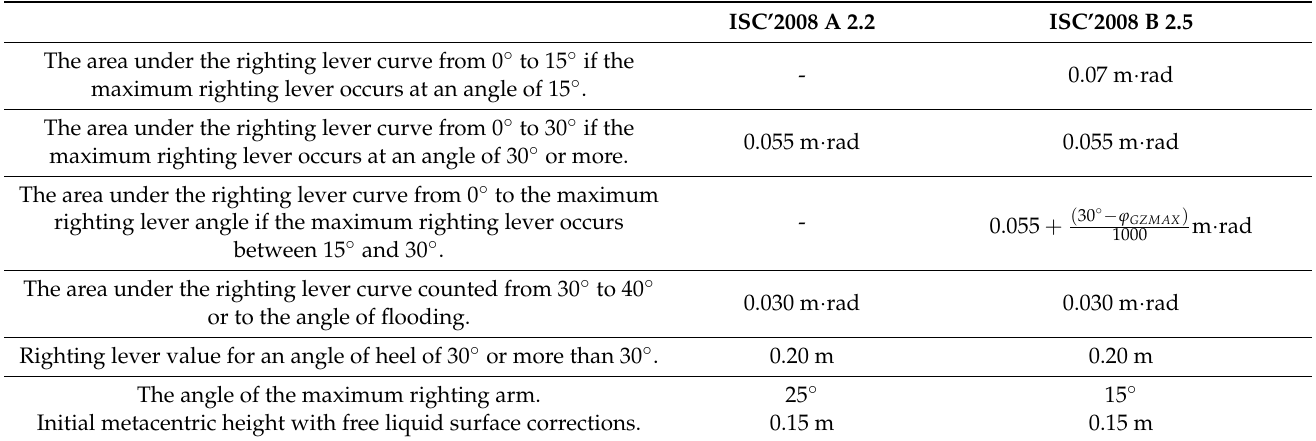
Table 1. Criteria of intact stability.